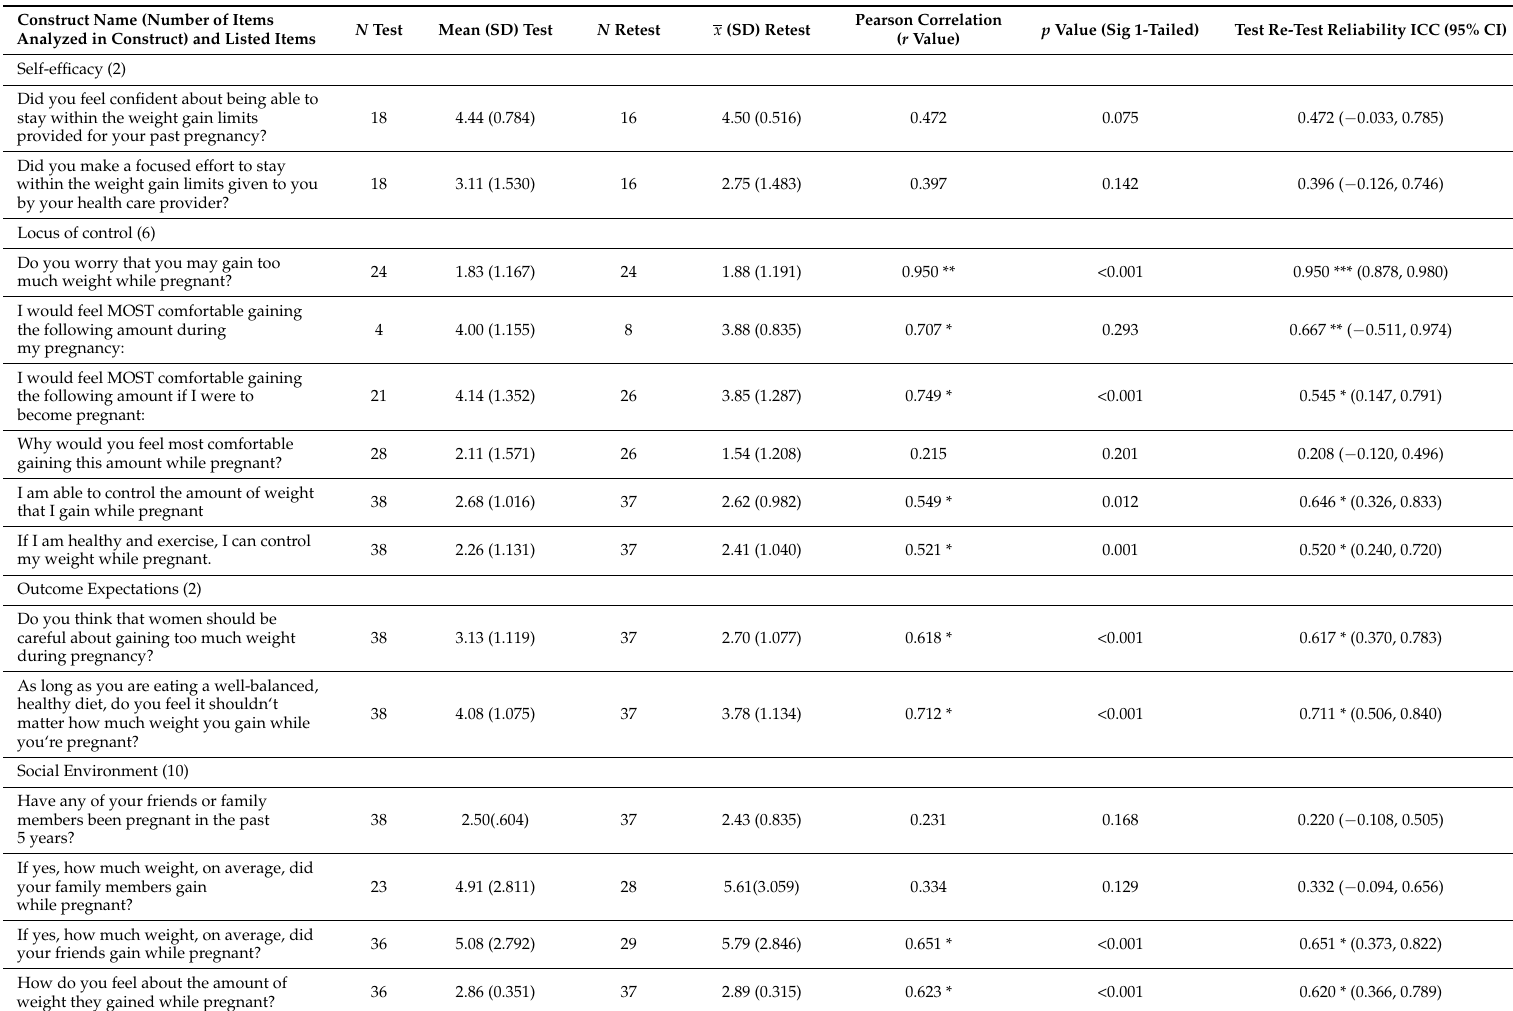
Table 3. Test-retest bivariate correlations for all